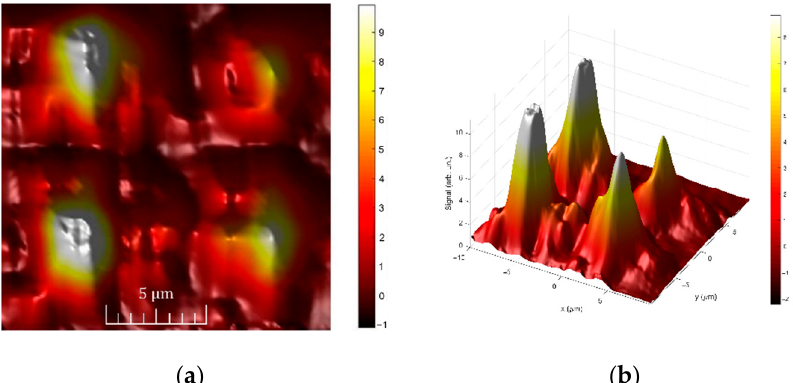
Figure 8. Near-field distribution of waveguide output for the 1 × 4 MMI splitter excited by a laser at 1550 nm [33]: ( a ) Top-down 2D graphic interpretation of the intensity distribution; ( b ) 3D interpretation of the intensity distribution.